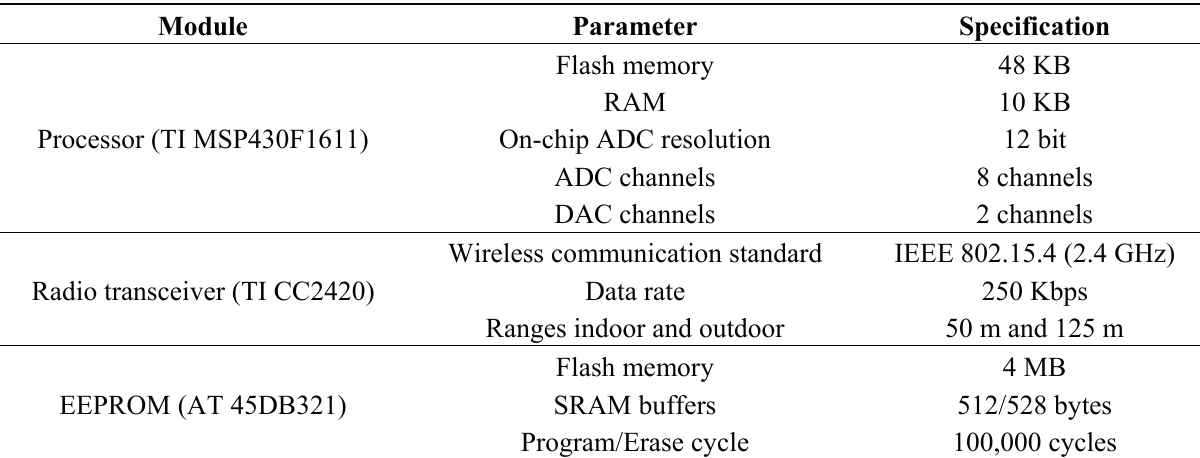
Table 1. Specification of the BSN nodes used in this